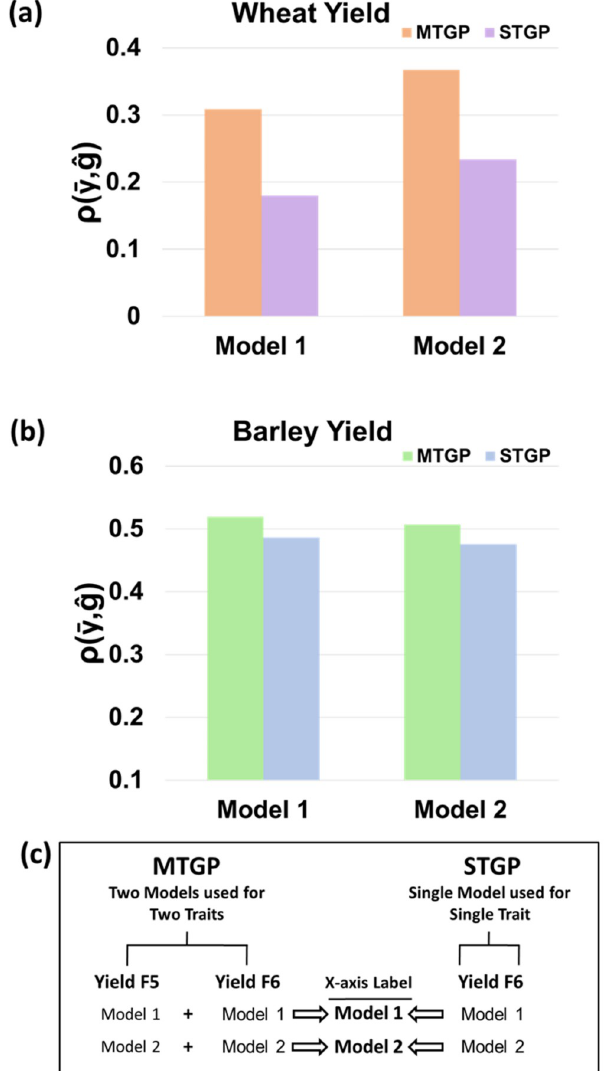
Fig 4. Comparison of MTGP and STGP approaches for predicting yield in the F 6 generation of winter wheat and spring barley. For MTGP, we used a training population, including F 5 as Trait I, Sets 1, 2, 3 for yield by F 6 as Trait II, and Set 4 to predict yield of F 6 (as a validation population). For STGP, we used Sets 1, 2, and 3 for yield by F 6 data as the training population to predict Set 4 for yield by F 6 (as a validation population). Fig 4c shows the corresponding models used for MTGP and STGP, respectively. The corresponding models are described in statistical model section in material and methods. where d( G ) is the mean diagonal element of the genomic relationship matrix, n is the number s of surrounding plots considered in the spatial effect, r is the number of replicates of corre- n sponding effects for each genotype when estimating line heritability, and r was one (1.0) n when estimating the narrow-sense plot heritability [33] based on the data of a single plot. The narrow-sense plot heritability was used to consider the random effects from the plot itself, whereas the line heritability was used to calculate the mean of effects from records across all replicates based on the same breeding line [6]. Line heritability is higher than plot heritability when there are more replicates in the experiment.